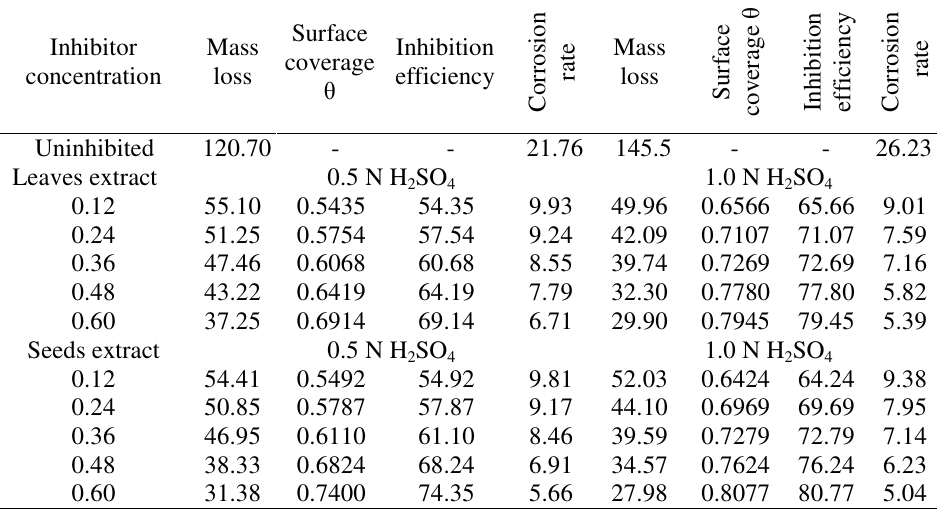
Table 1. Mass loss, surface coverage, inhibition efficiency and corrosion rate for aluminium in 0.5 N and 1.0 N H SO solution with methanolic extract of Citrullus colocynthis for 24 h 2 4 at 298±0.1